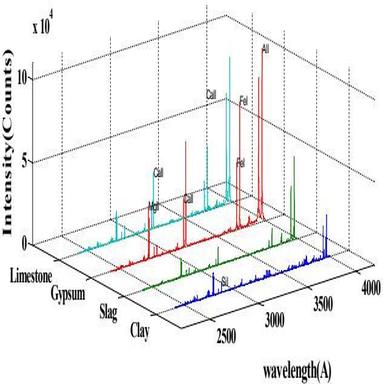
The resolved lines of the most intense emission lines for the elements present in the LIBS spectra.